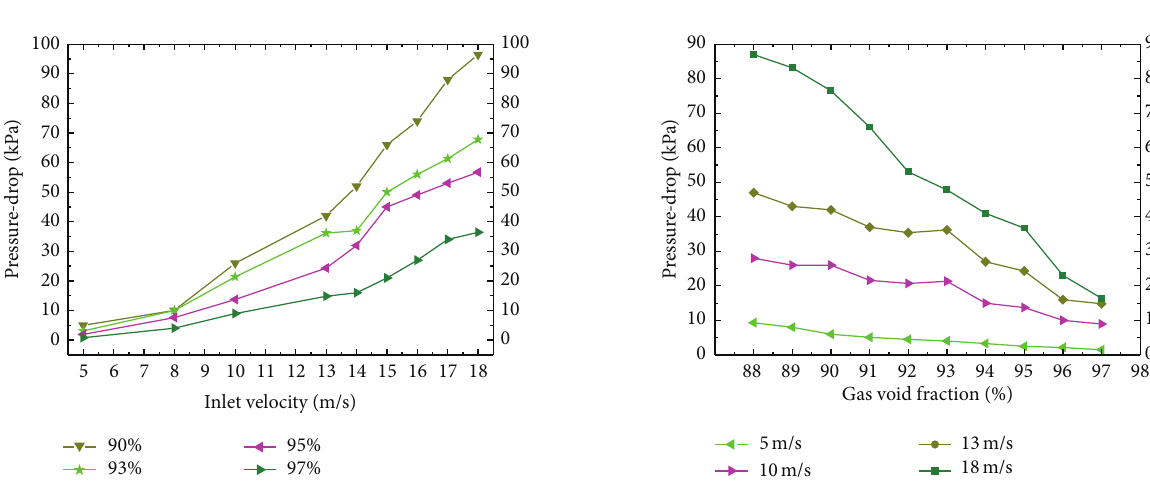
Figure 6: The influence of gas void fraction on the pressure-drop under different inlet